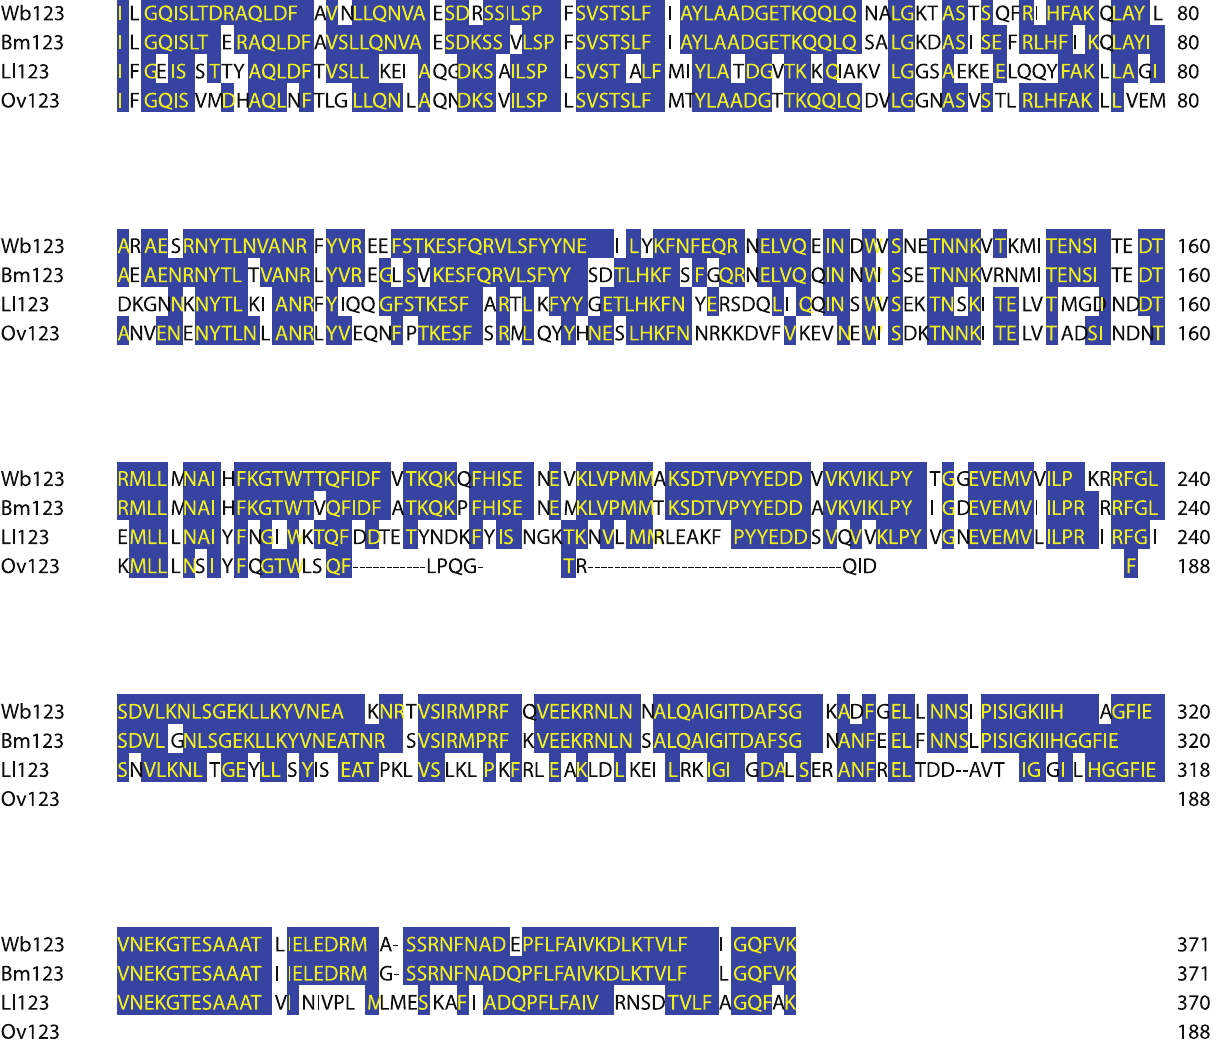
Figure 1. Sequence alignment of Wb123. Sequence alignment of Wb123 with homologous proteins in Brugia malayi (Bm123), Loa loa (Ll123), and Onchocerca volvulus (Ov123). Boxed blue amino acids are those that show 100% conservation with those of Wb123.